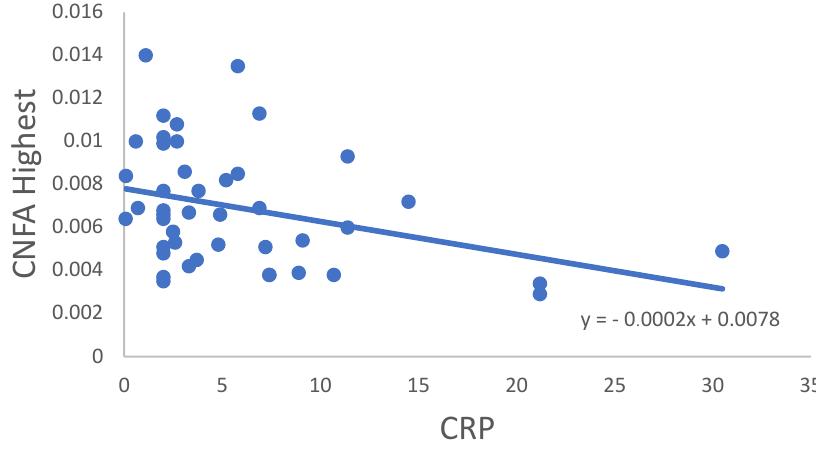
Figure 4. Correlation of CNFD Highest and Schirmer’s-test results.